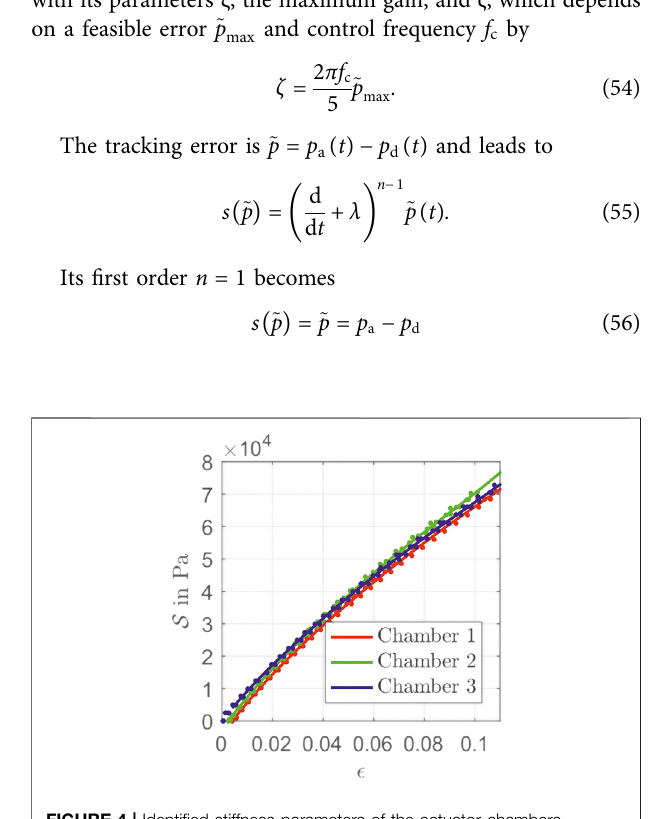
Figure 4 . The values of the individual chambers differ due to